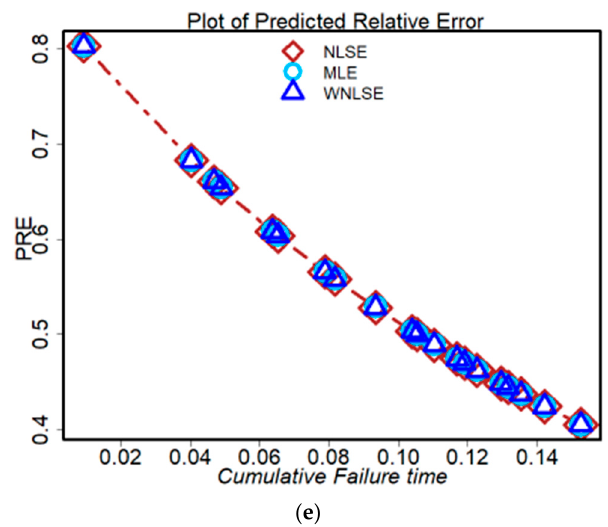
Figure 8. PRE for the estimating techniques for NHPP–NPF compared with five datasets: ( a ) DS1, ( b ) DS2, ( c ) DS3 ( d ) DS4, and ( e ) DS5.